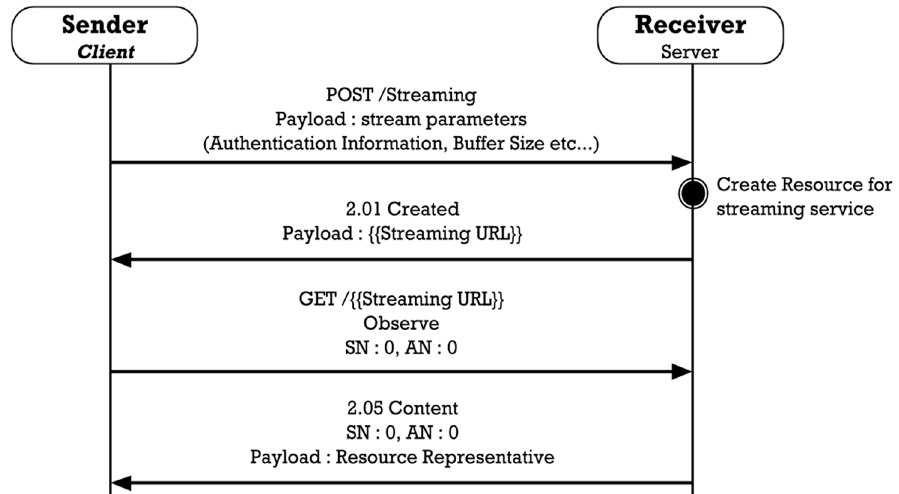
Figure 10. CoAP-SC Initialization.